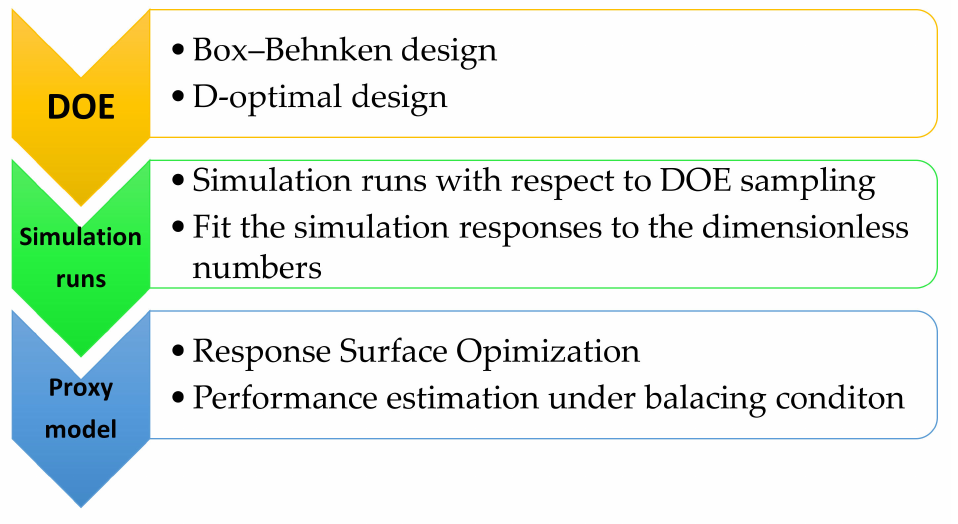
Figure 1. Flowchart of research